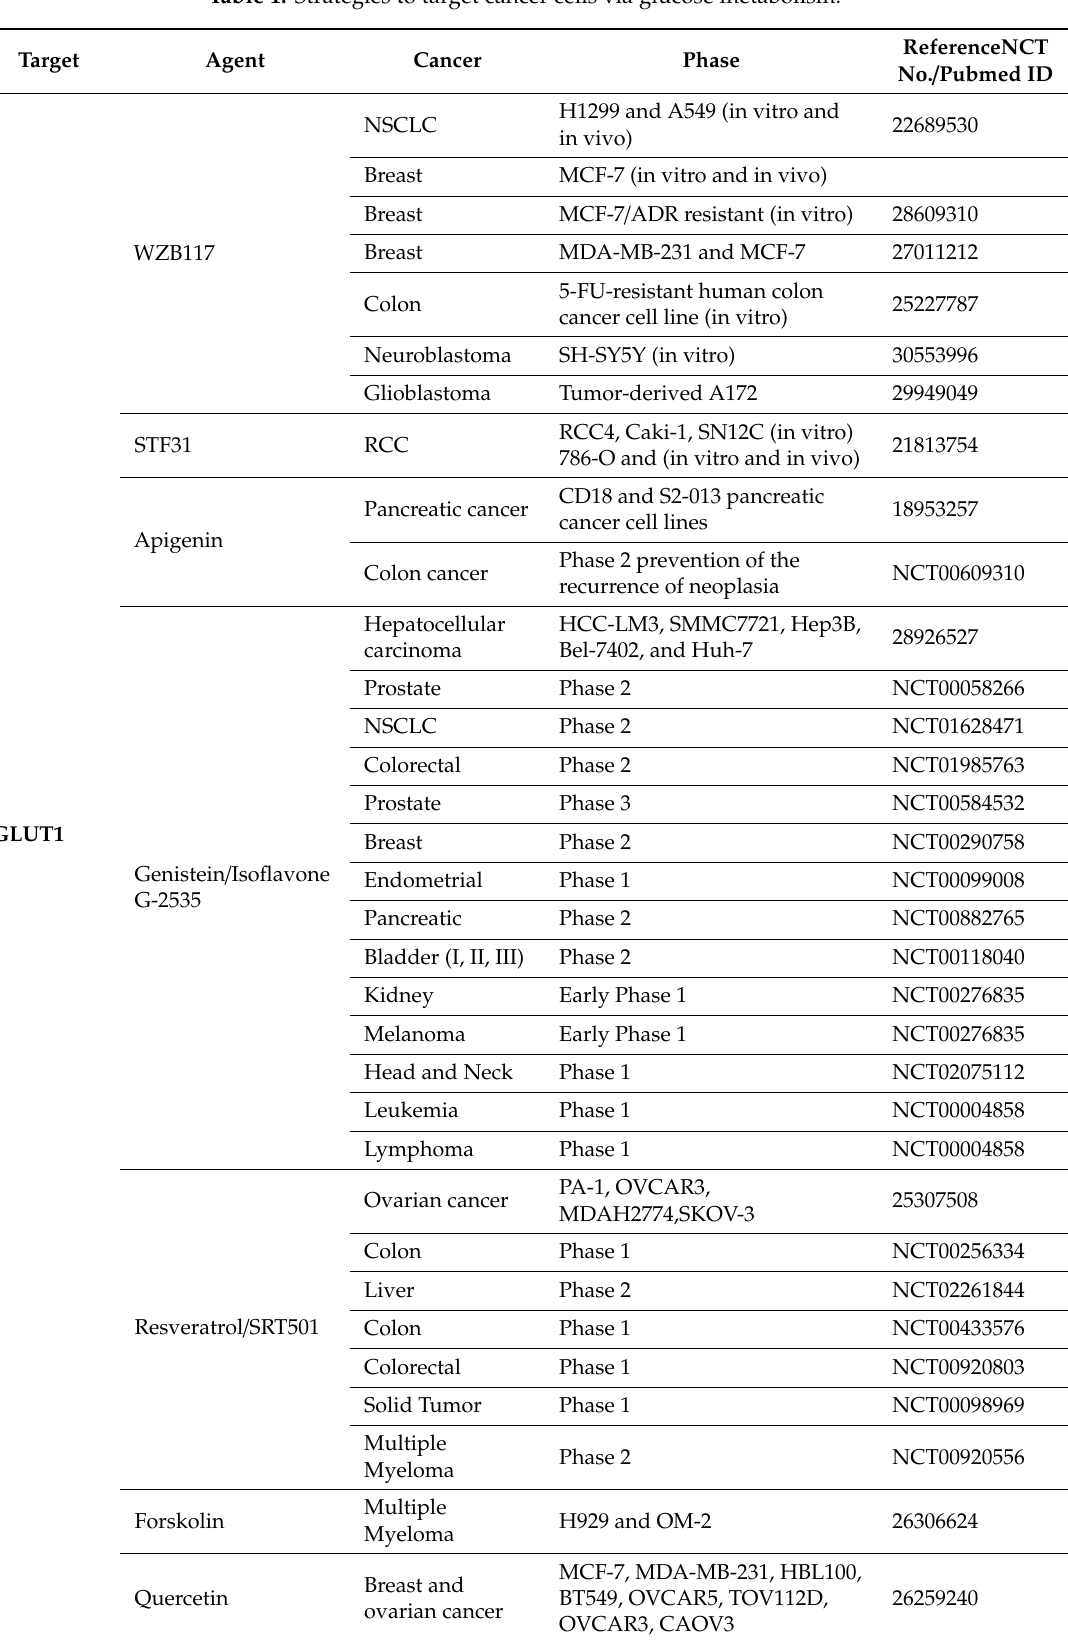
Table 1. Strategies to target cancer cells via glucose